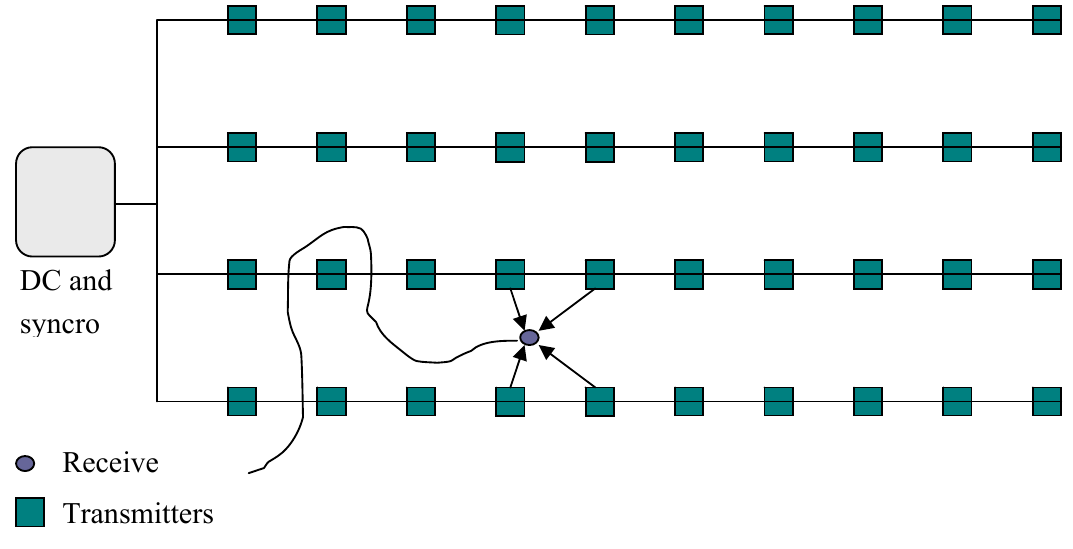
Figure 1 . General description. Transmitters on the ceiling and synchronized by a common DC with clock